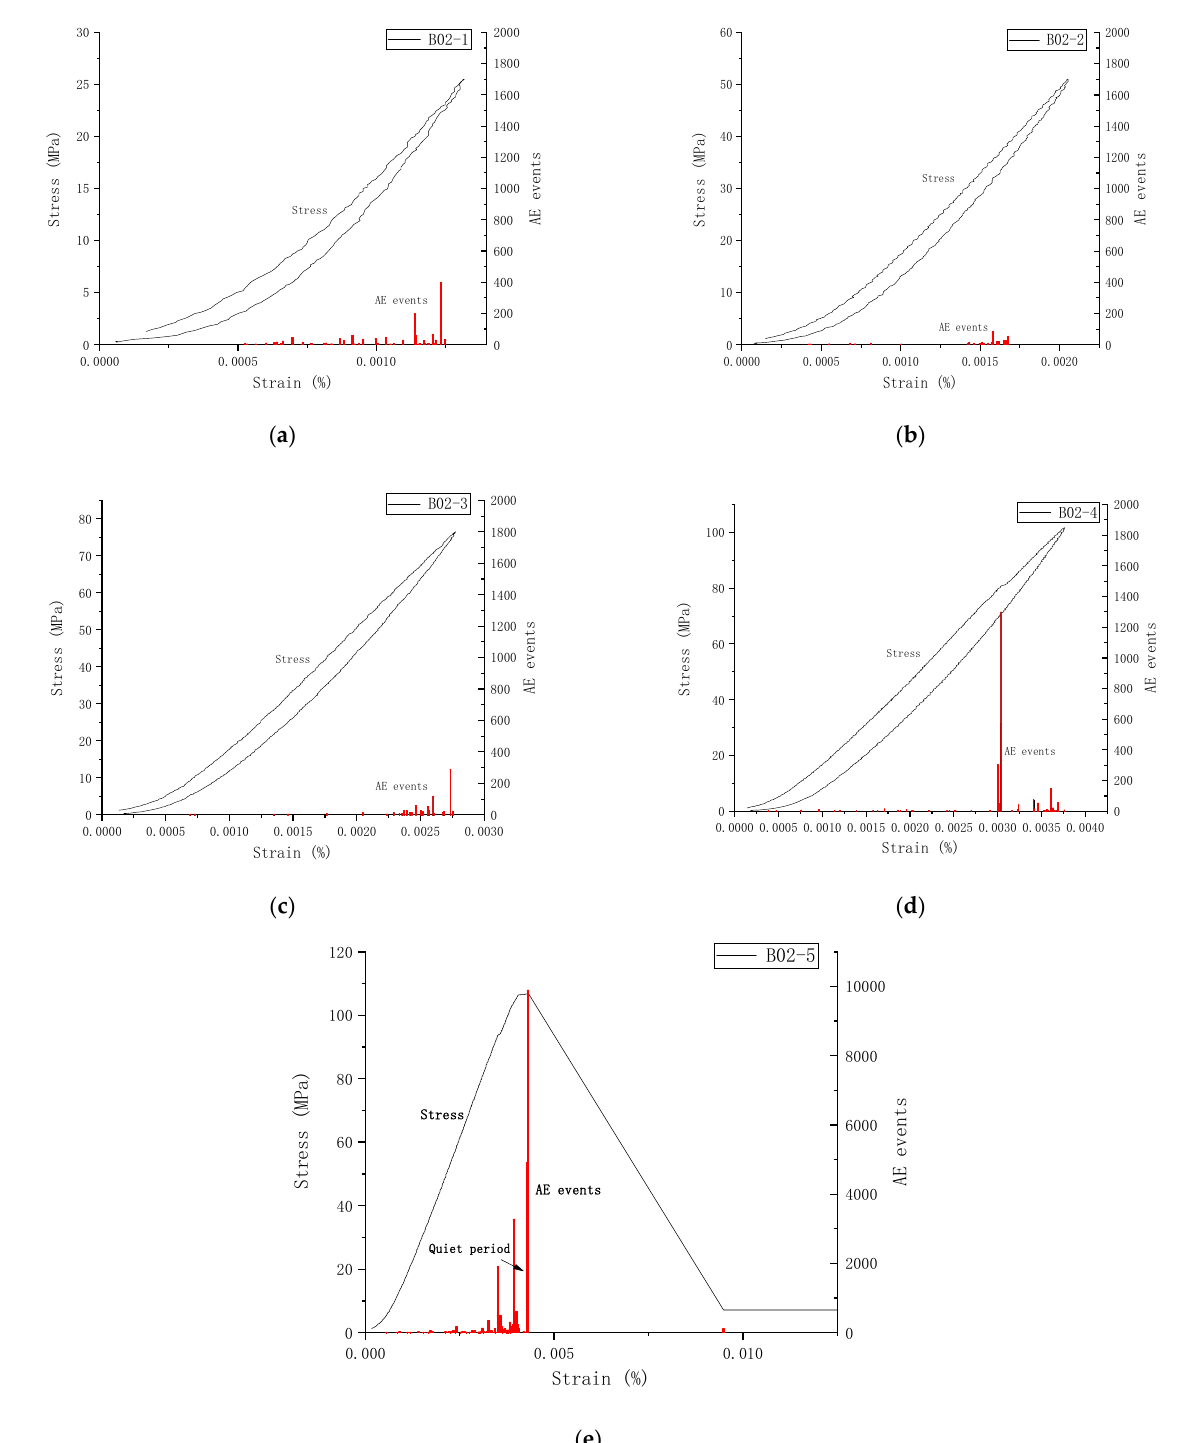
Figure 16. Relationship between stress–strain curve and AE events of each cycle of rock sample. ( a ) Level 1 complete cycle; ( b ) Level 2 complete cycle; ( c ) Level 3 complete cycle; ( d ) Level 4 complete cycle; ( e ) Level 5 uniaxial compression.